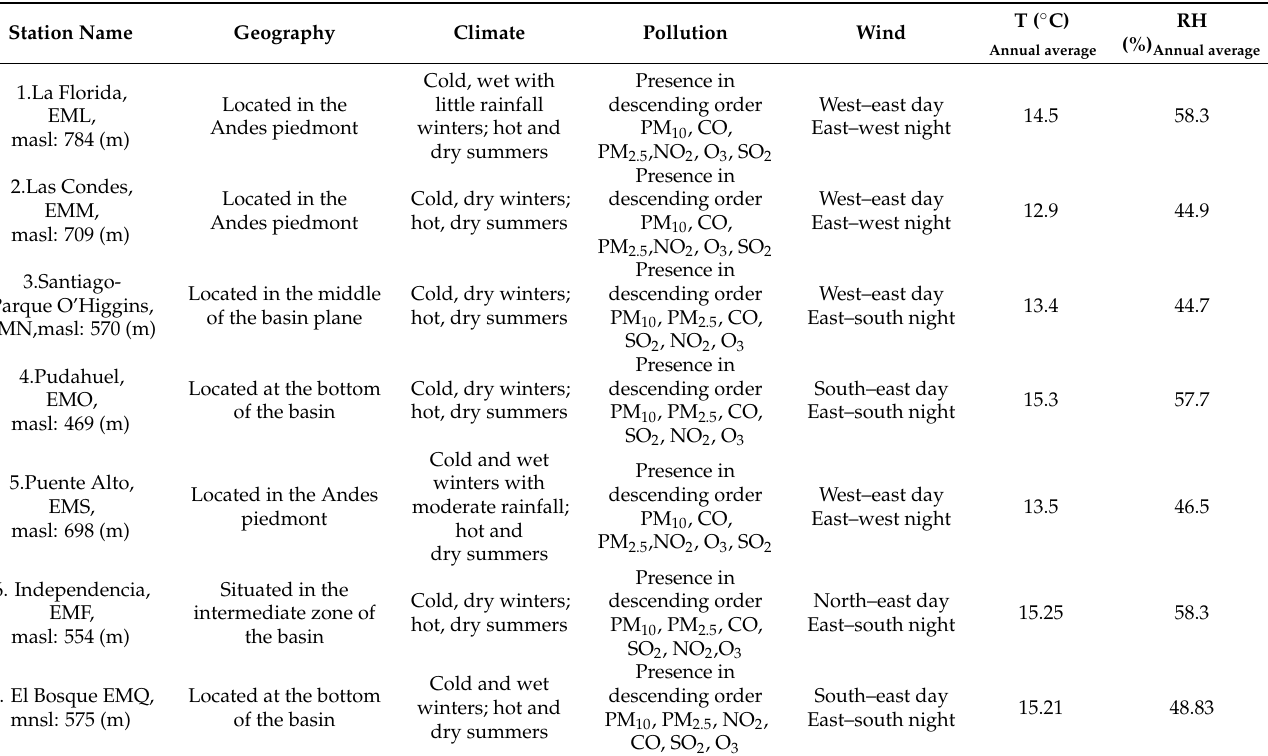
Table 1 contains the main physical, climatic, geographic, pollution and meteorological variables of the study sites shown in Figure 2. Table 1. For each locality studied, information on station name (with SINCA code in capital letters and meters above sea level (masl)), geography, climate, pollution, dominant wind direction (W), annual average temperature (T) and annual average relative humidity